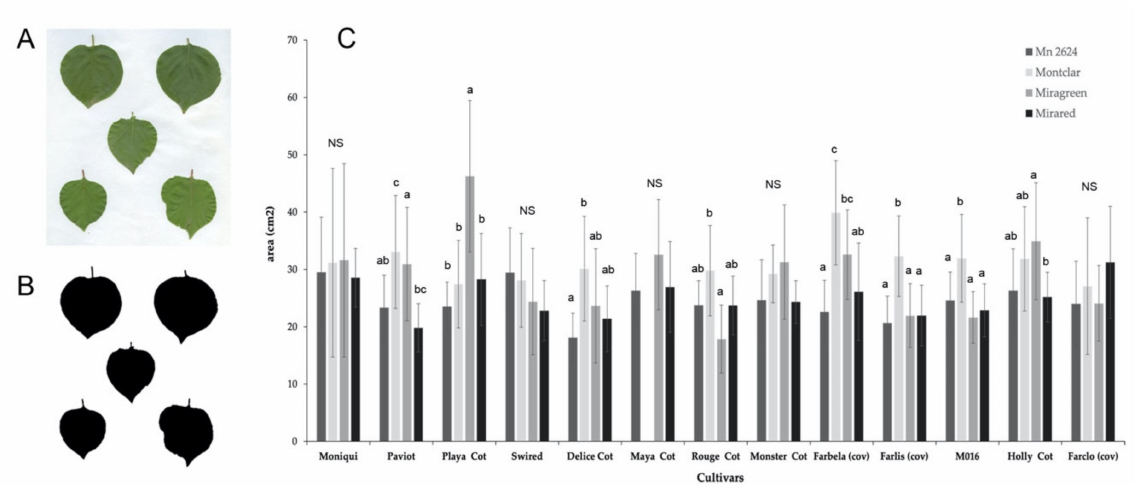
Figure 6. Effect of graft combinations on leaf area from 13 apricot cultivars grafted on four rootstocks (‘MN2624’, ‘Montclar’, ‘Miragreen’, and ‘Mirared’) one year after grafting. ( A ) Original leaves images from the graft combination ‘Paviot grafted on Montclar’, ( B ) image converted to black and white from ImageJ, which computes the total area of all leaves. ( C ) Graphical representation of the average of 10 leaves chosen randomly from the middle zone of three replicates of each cultivar for each rootstock. Values are means ± SE of three replicates. Different letters indicate significant differences at p < 0.05 within each cultivar for different rootstocks according to Tukey test; ‘NS’ indicates non-significant differences.